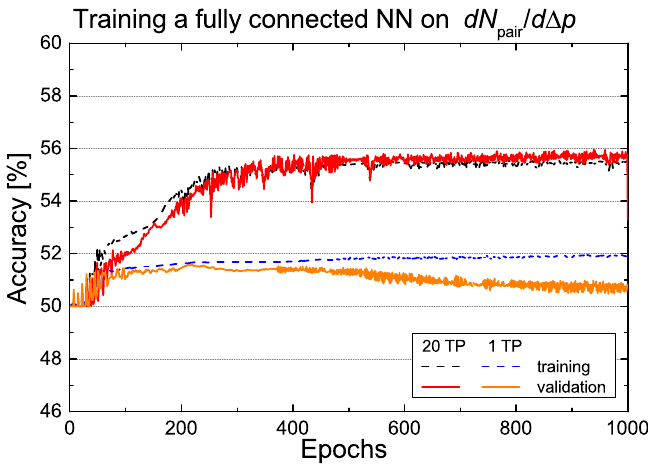
Figure 6 . Training and validation accuracy as function of the number of training epochs for the fully connected neural network, training with event-by-event distributions of the momentum di(cid:11)erence of baryon pairs. We compare results for TP=1 and TP=20